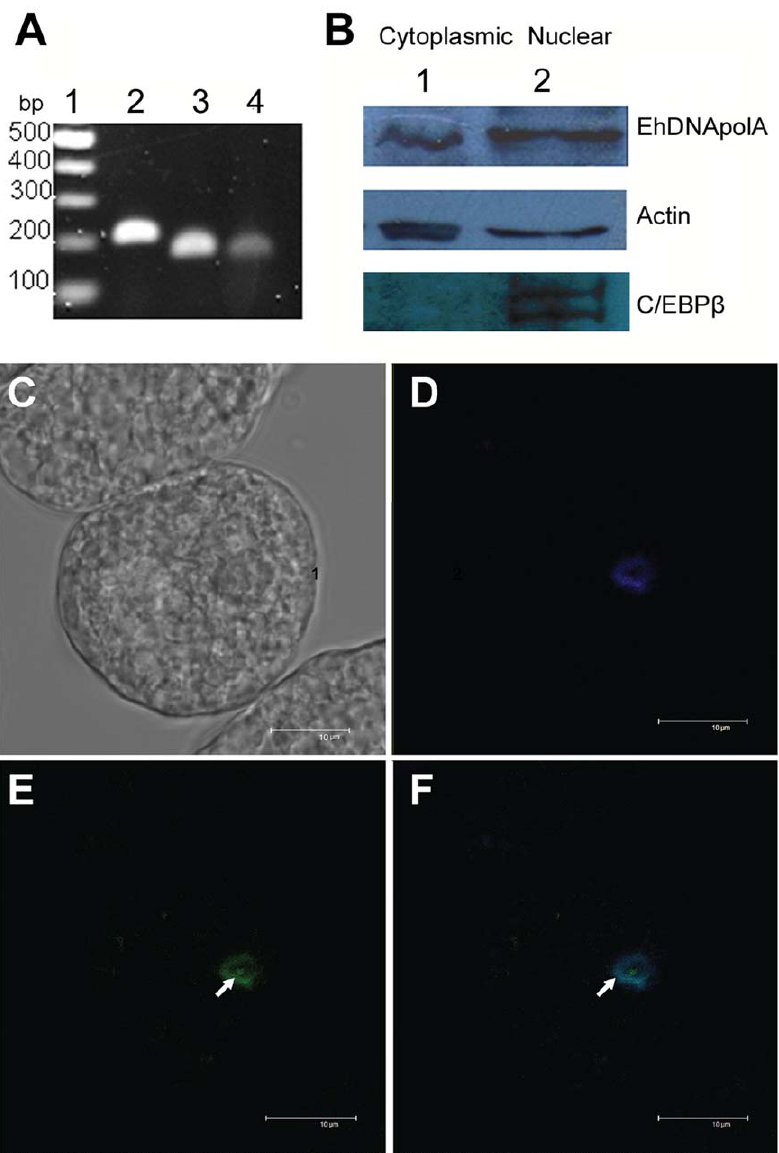
Figure 7. Cellular identification and localization of EhDNApolA. ( A ) RT-PCR using total RNA from E. histolytica trophozoites grown in basal culture conditions 1% Agarose gel stained with ethidium bromide showing the RT-PCR products of motifs A (lane 3) and C (lane 4) of the EhDNApolA gene. The RT-PCR product of the actin gene control is shown in lane 2. ( B ) Immunodetection of EhDNApolA. Western blot assays using, cytoplasmic extracts (lane 1), and nuclear extracts (lane 2) of E. histolytica ’s trozophoites against mouse polyclonal anti- EhDNApolA antibodies (upper pannel). Control using mouse polyclonal anti-actin antibodies (middle panel) and anti- C/EBP b antibodies (lower panel) ( C–F ) Cellular localization of EhDNApolA analyzed by confocal immunofluorescence microscopy. ( C ) Nomarsky image of a single E. histolytica cell stained with 4 9 ,6-diamidino-2- phenylindole (DAPI) and incubated with anti-EhDNApolA antibodies treated with FITC-labeled secondary antibodies ( D ) fluorescence signal generated by DAPI ( E ) fluorescence signal generated by the binding of the FITC-conjugated antibody to anti-EhDNApol A antibody ( F ) Merge image of the fluorescence emitted by DAPI and FITC.